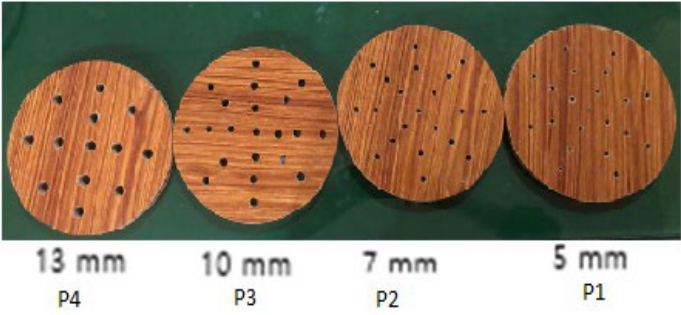
Figure 6. Shutters of different